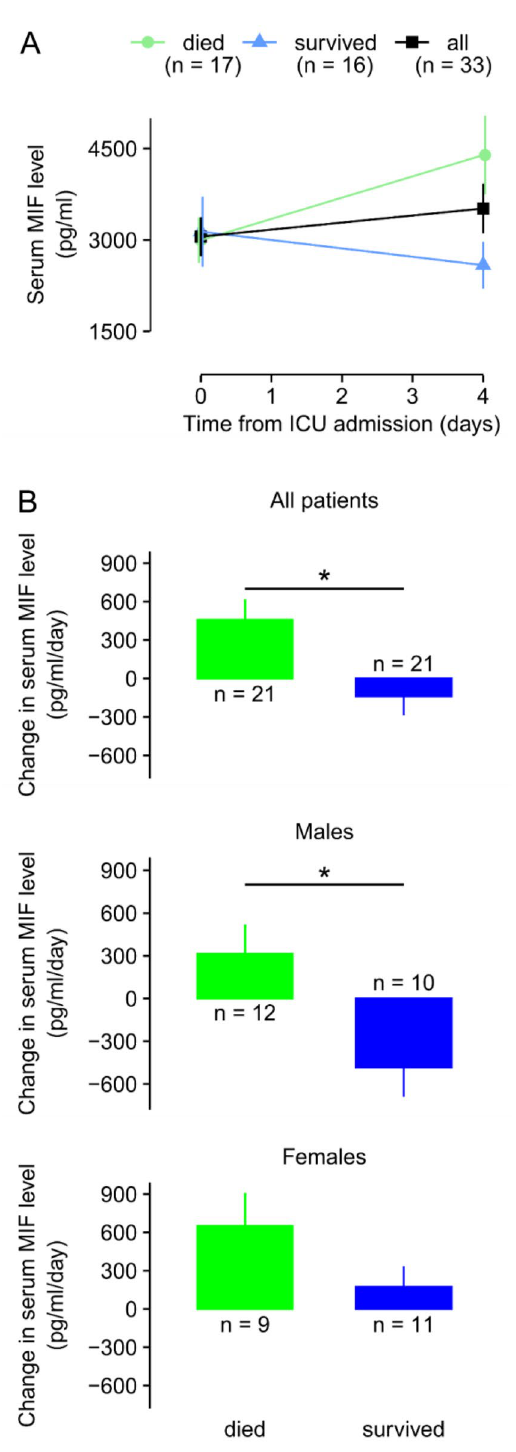
Figure 4. The kinetics of serum macrophage migration inhibitory factor (MIF) levels in septic patients at the intensive care unit (ICU). ( A ) The mean absolute serum levels of MIF in all, deceased, and survived septic patients on day 0 and 4 from admission to the ICU. ( B ) The mean daily changes of serum MIF levels in deceased and survived patients based on data obtained from both sexes (top), males (middle), and females (bottom). The number of patients (n) is indicated in the figure in each group. * p <